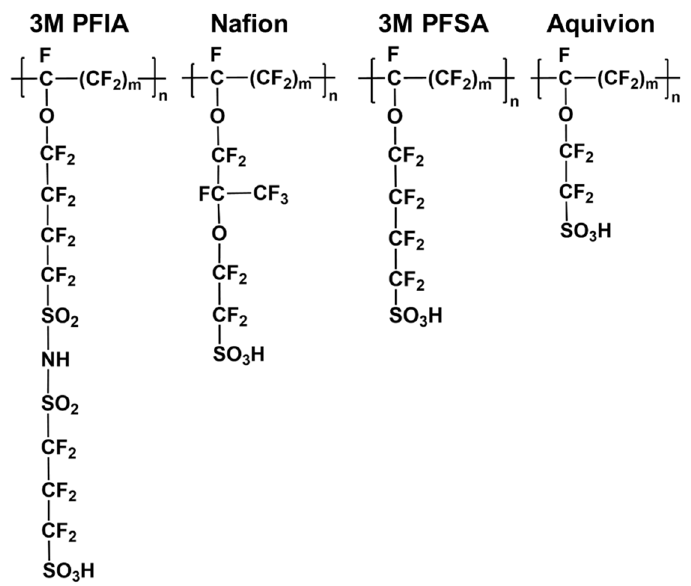
Figure 7. The chemical structures of 3M PFIA ionomer, Nafion ionomer, 3M PFSA ionomer, and Aquivion ionomer [108,112]. Table 1. The commonly used commercial ionomer dispersion solutions and their related parameters [109,121–124].